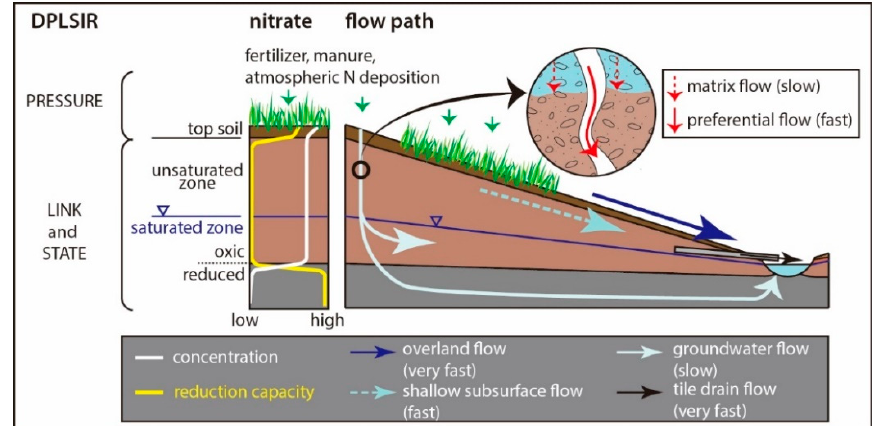
Figure 2 . Conceptual understanding of the vertical distribution of nitrate from the agricultural system to the hydrogeological system and pathways in the hydrogeological system. The agricultural system is represented by the pressure indicators and the hydrogeological system is described by the link and state indicators. The reduction capacity is defined as the sum of solid nitrate-reducing compounds, e.g., pyrite and organic matter.